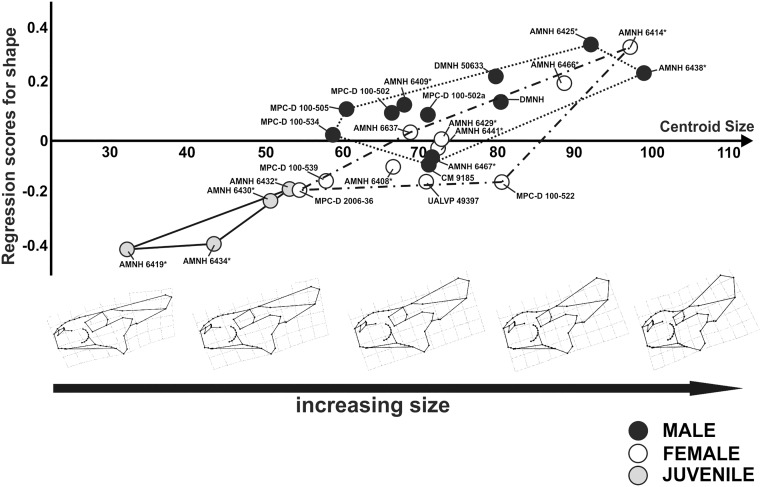
Visualization of shape-size relationship via CCA analysis for cranial shape in lateral view and cranial shape changes associated with the increase of size.Asterisks indicate specimens shared with Dodson [25].